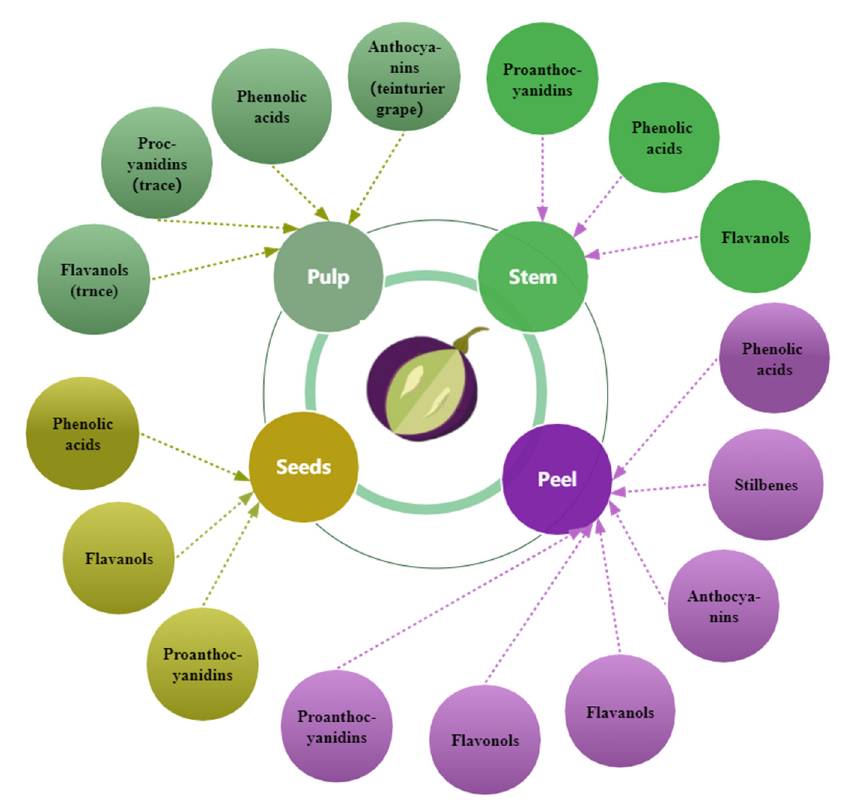
Figure 3. The primary distribution of phenols in grapes.